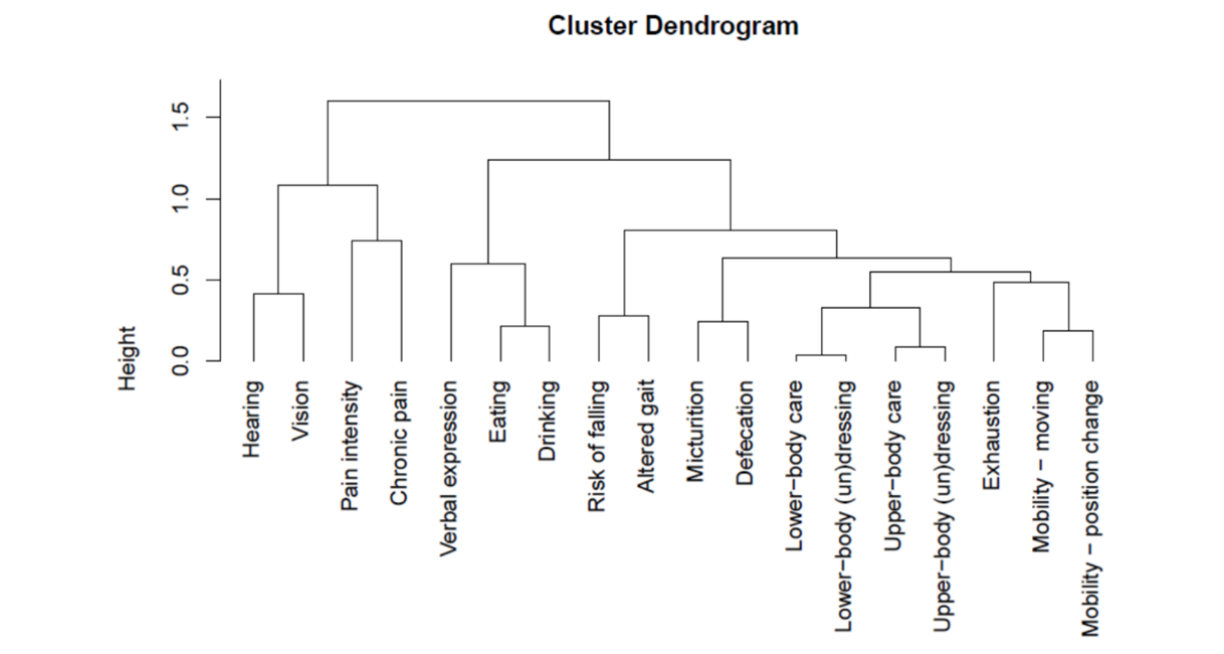
Figure 4. Dendrogram of the somatic health status